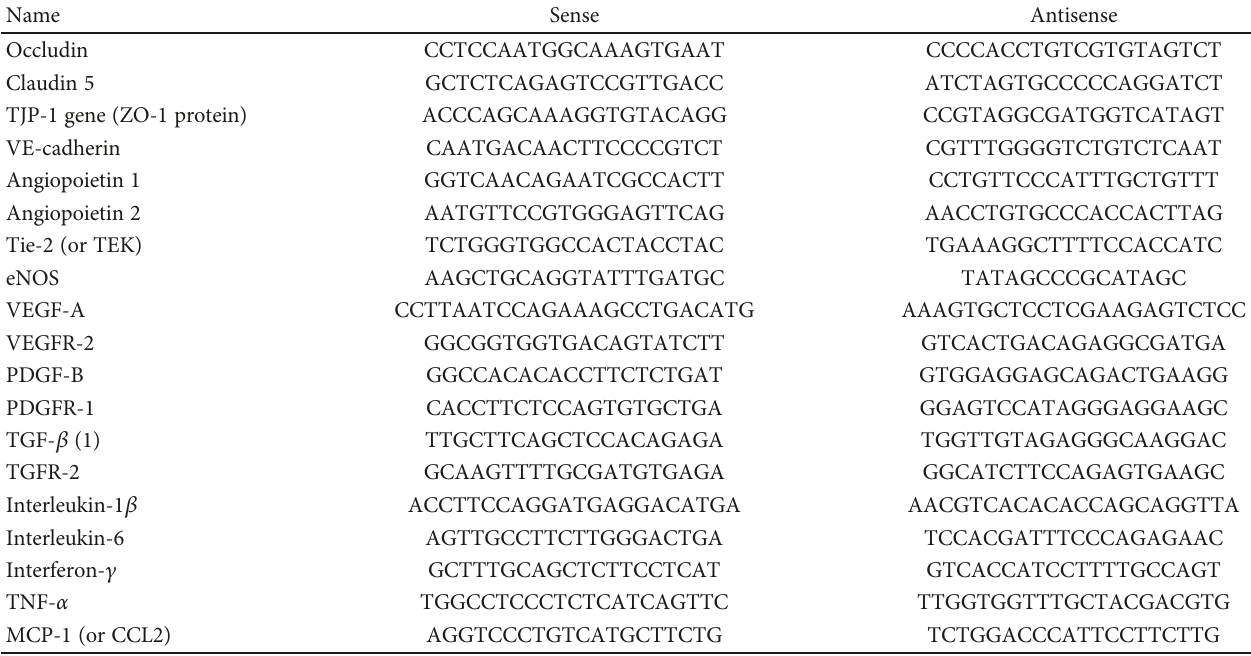
Table 1: Sense and antisense primer sequences used for